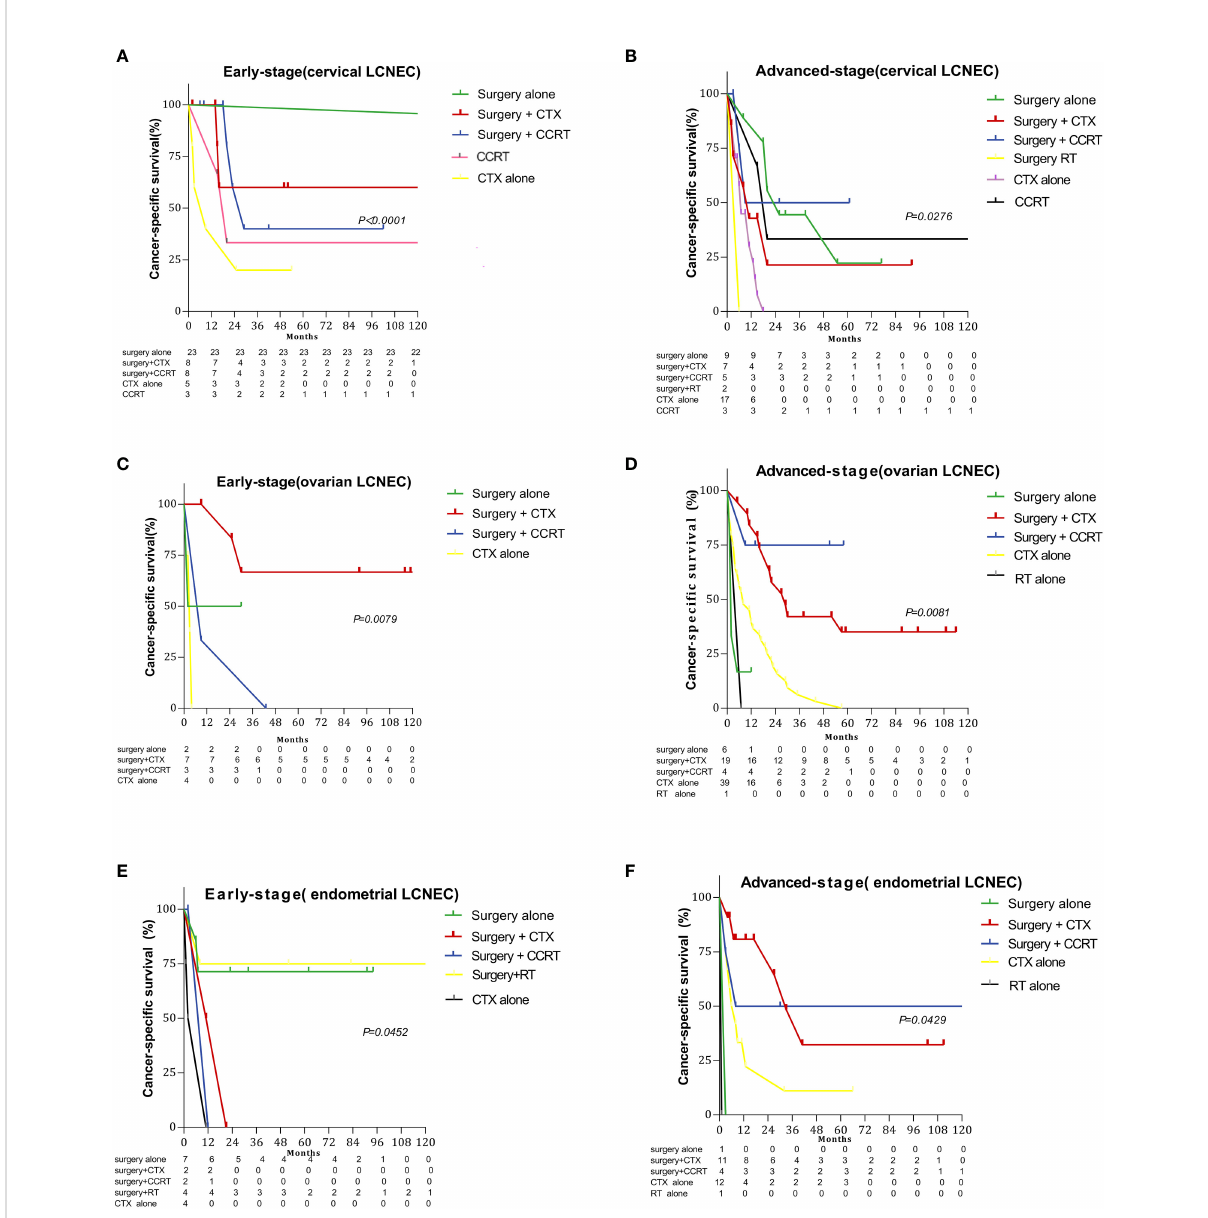
FIGURE 4 Survival curves for gynecologic LCNEC patients with early- and advanced-stage disease for different treatment regimens: (A) cancer-speci fi c survival (CSS) in the early stage with cervical LCNEC; (B) cancer-speci fi c survival (CSS) in the advanced stage with cervical LCNEC; (C) cancer- speci fi c survival (CSS) in the early stage with ovarian LCNEC; (D) cancer-speci fi c survival (CSS) in the advanced stage with ovarian LCNEC; (E) cancer-speci fi c survival (CSS) in the early stage with endometrial LCNEC; (F) cancer-speci fi c survival (CSS) in the advanced stage with endometrial